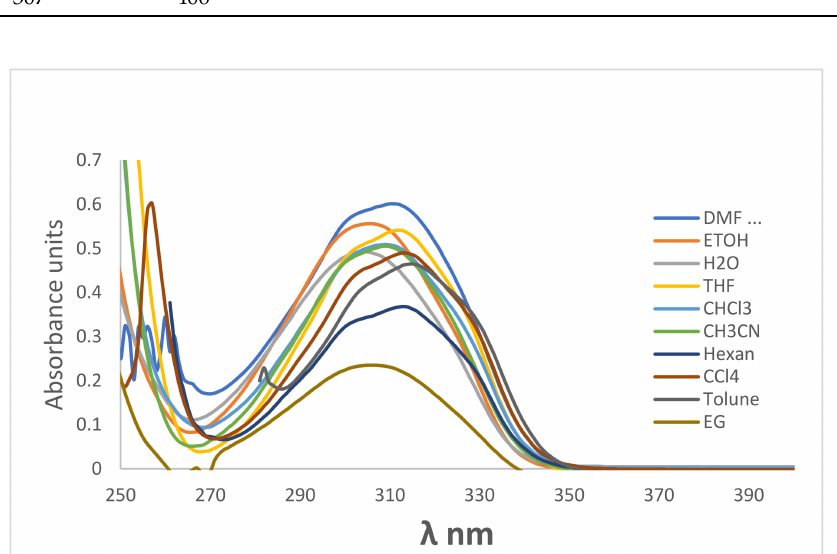
Figure 8. Absorption spectra of 2 × 10 − 6 M coumarin 4 in different